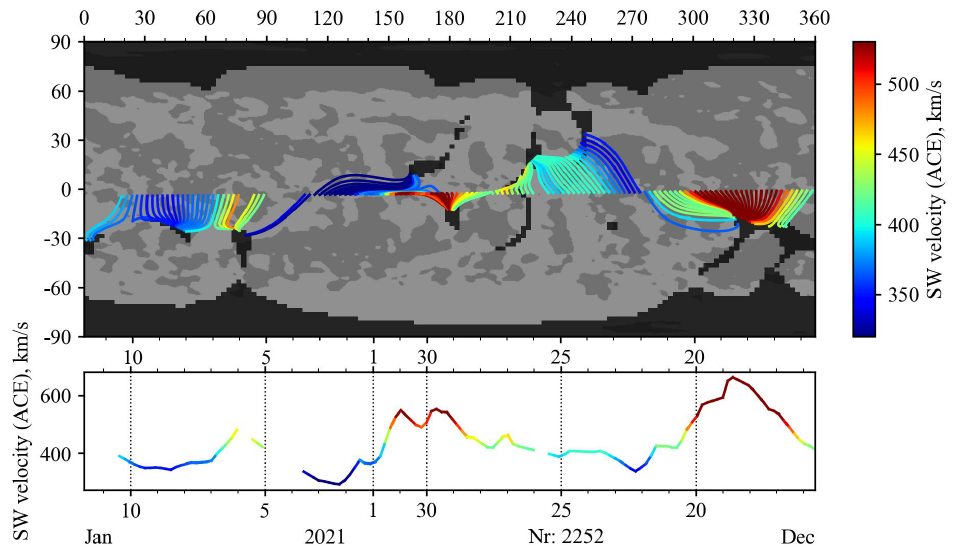
Figure 2. Open field lines in the ecliptic plane, calculated from magnetograph STOP data, 2252 CR (top panel). The dark regions correspond to the CHs, while the gray and light gray areas depict the different polarities of the photospheric field. The corresponding SW velocity according to the ACE data (bottom